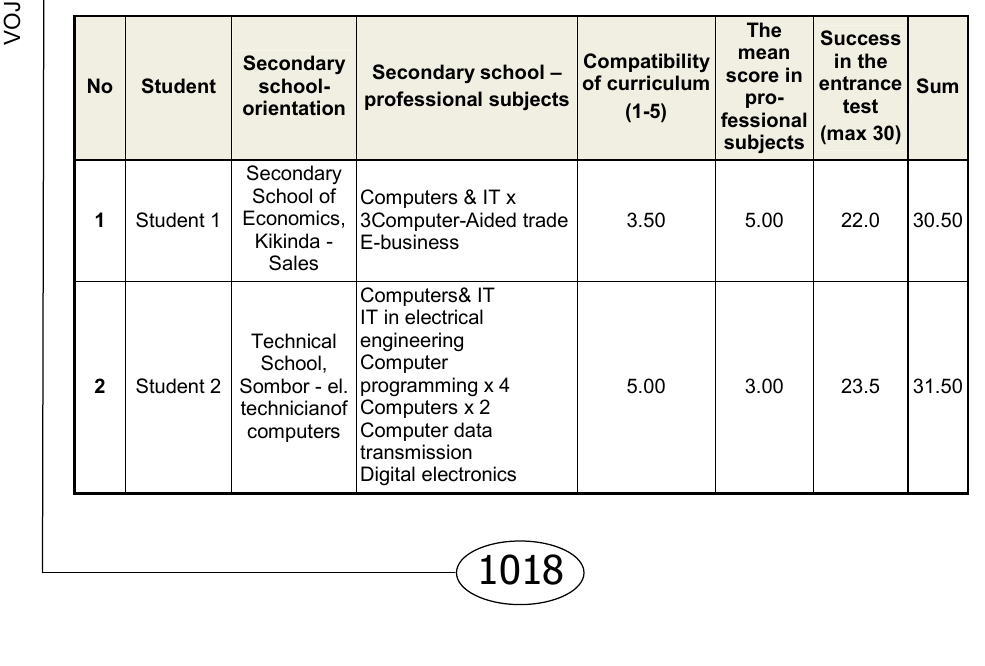
Table 1 – Background Informationon the Course Participants–Prior Knowledge, Interest Таблица 1 – Данные о слушателях курса – предзнания ,